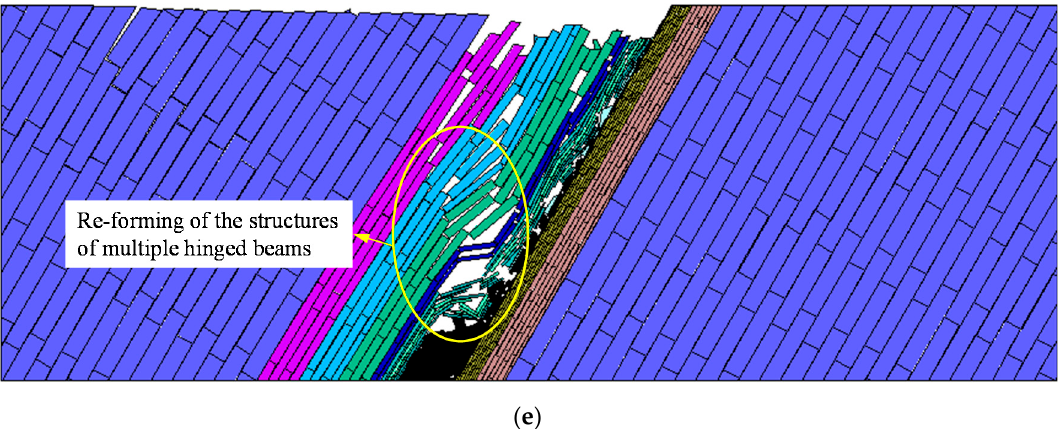
Figure 7. Simulated roof breakage in horizontal section mining of steeply inclined extra ‐ thick coal seams (SIETCS): ( a ) Mining in the 12th section; ( b ) Mining in the 17th section; ( c ) Mining in the 19th section; ( d ) Mining in the 21st section; and ( e ) Mining in the 23rd section.